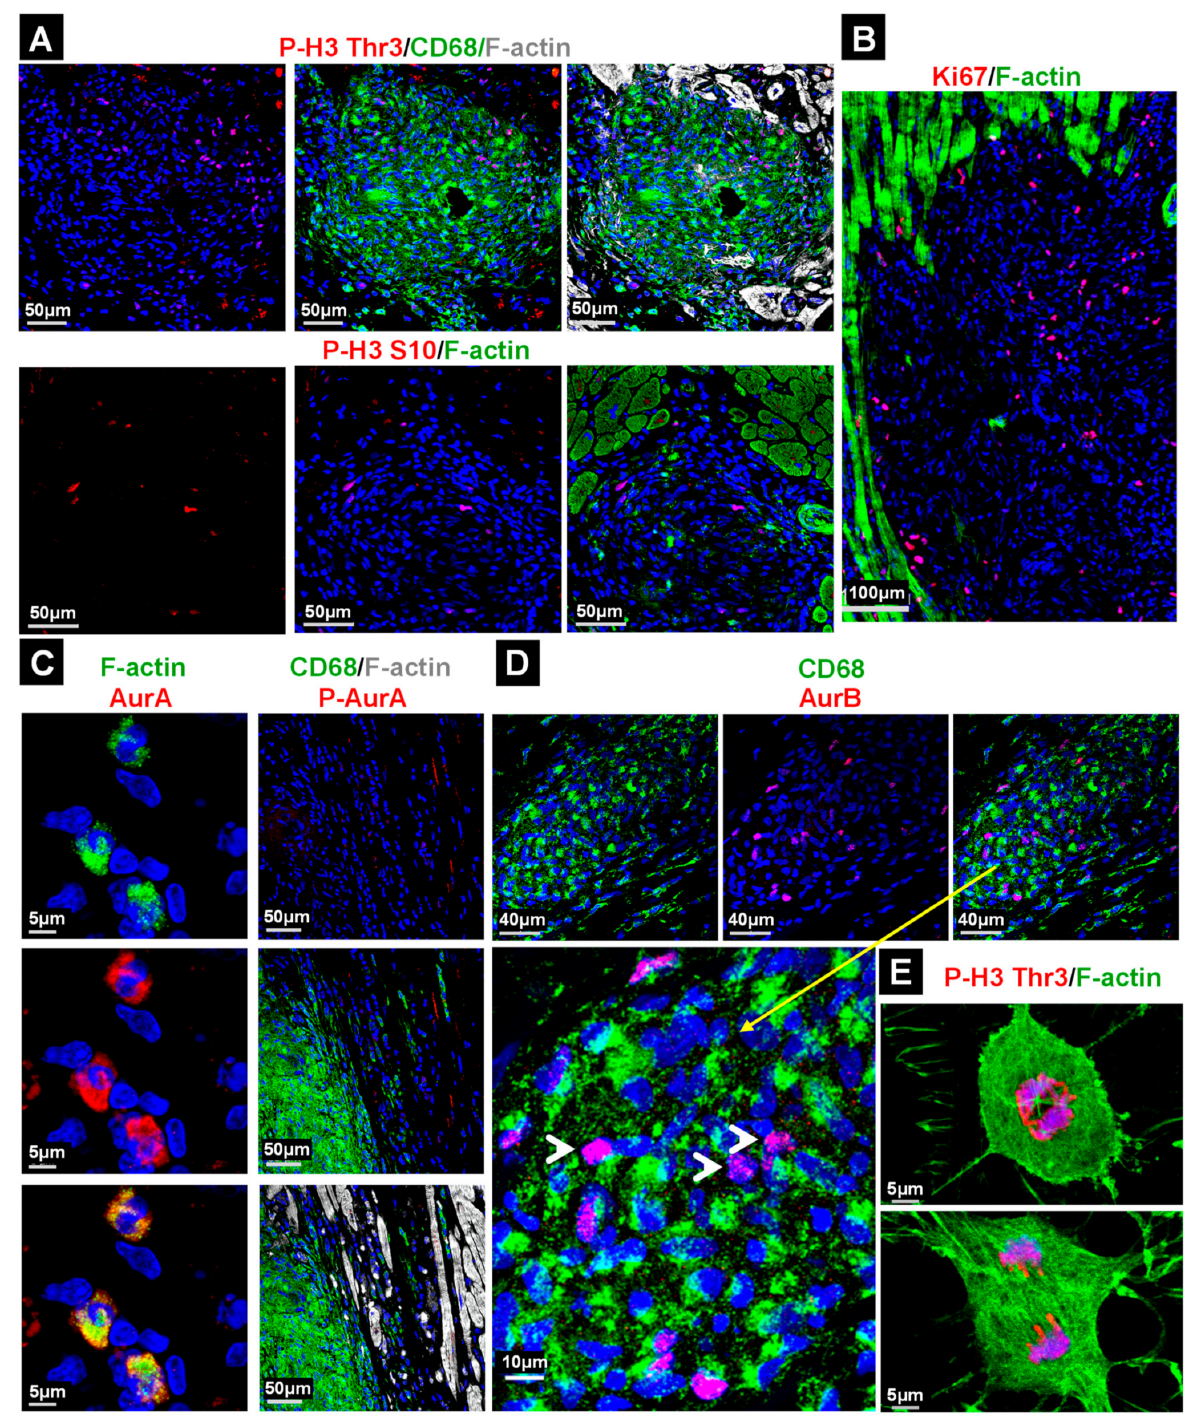
Figure 4. Cell cycle marker-positive macrophages reconstitute the minor cell pool in granulomata. ( A ) Phosphorylation of serine 10 (S10) and threonine 3 (Thr3) in histone H3 (P-H3) indicate cell cycle activation. ( B ) Ki67-positive cells are present in- and outside of granulomata. ( C ) Aurora A (AurA), filamentous actin (F-actin) and phospho-Aurora A (P-AurA, Thr288) highlight some cells in granulomata. ( D ) The costaining of Aurora B (AurB) with CD68 reveals mostly proliferating non-macrophages in GL (enlarged image, yellow arrow and white arrow heads). Note that none of the utilized cell cycle markers are indicative for a mitotic cell in of themselves. Since all used antibodies originate from rabbits, simultaneous staining of these markers was not performed. ( E ) Comparison images of mitotic non-cardiomyocytes in the culture. The nuclei are stained blue with